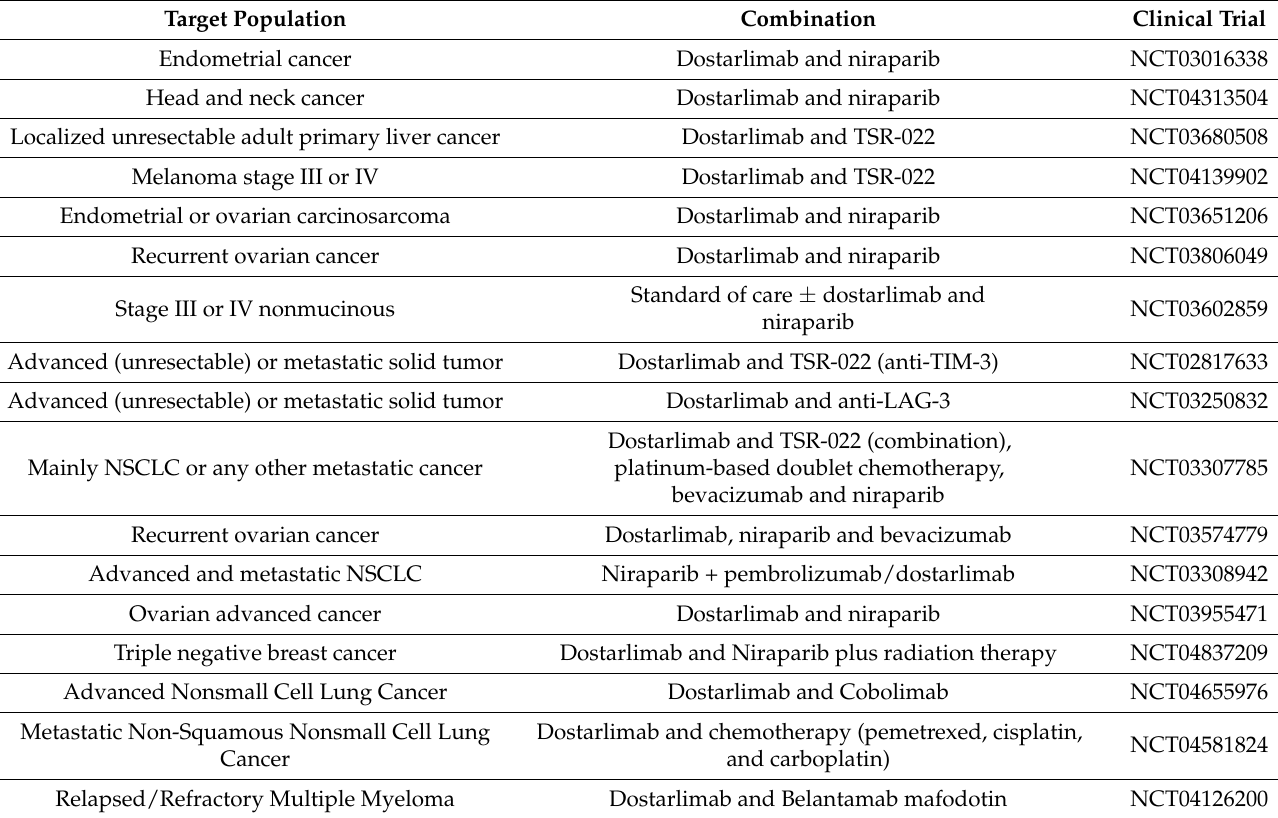
Table 2. Clinical trials testing the combination of drug Dostarlimab with other